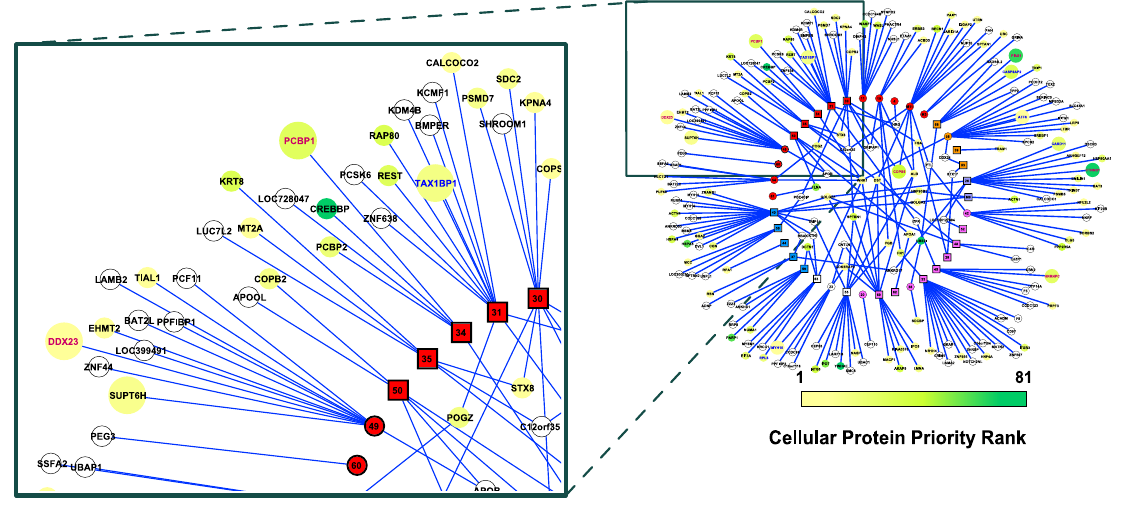
Figure 3. The MHV-68-cellular protein interactome. Viral proteins (rectangles) are displayed as a ring and are grouped according to their functional annotation (colors are as described in legend to Fig. 2). Cellular proteins (circles) that interacted with one viral protein are located outside of the ring, whereas those that interacted with multiple viral proteins are located inside. Cellular proteins are colored according to the priority rank, with unranked proteins are shown in white. The size of the circle indicates the magnitude of the effect on MHV-68 lytic replication caused by inhibiting the expression of the cellular gene by RNAi. Large circles imply greater effect; small circle, no effect or not tested. Font color of the cellular protein label indicates the direction of the effect on MHV-68 lytic replication (red, inhibiting expression of the cellular gene increased replication, dark green; inhibiting expression of the cellular gene decreased replication, black, no effect or not tested).